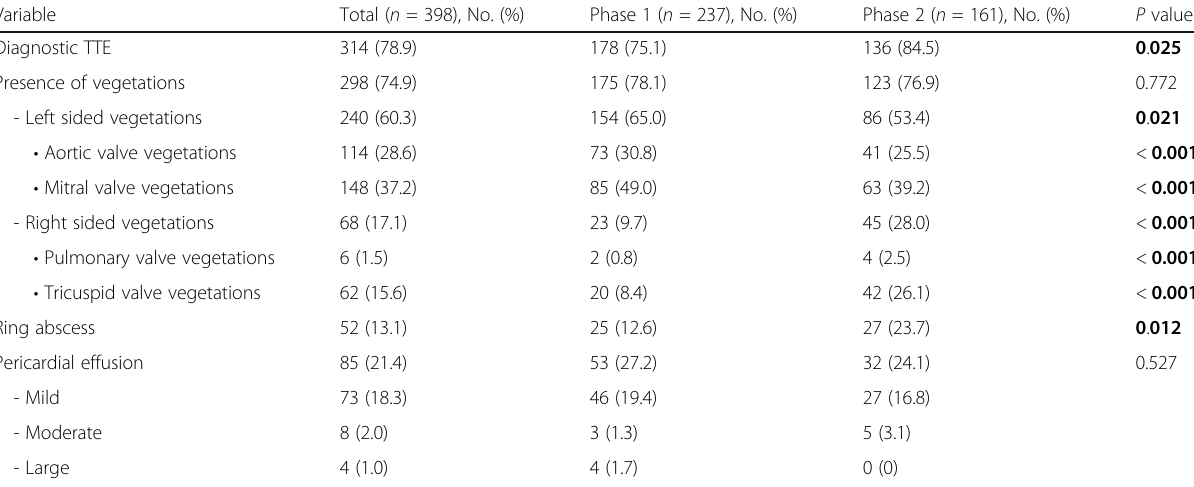
Table 2 Echocardiography findings Variable